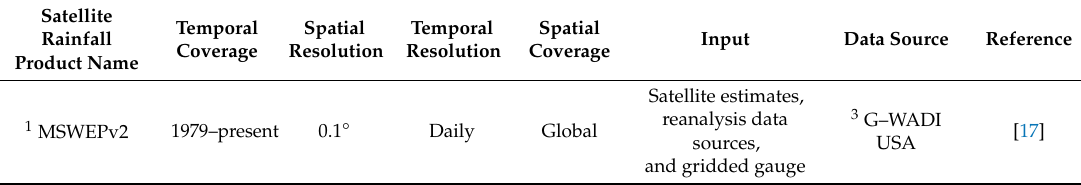
Table 1. Summary of the satellite rainfall products evaluated in the current